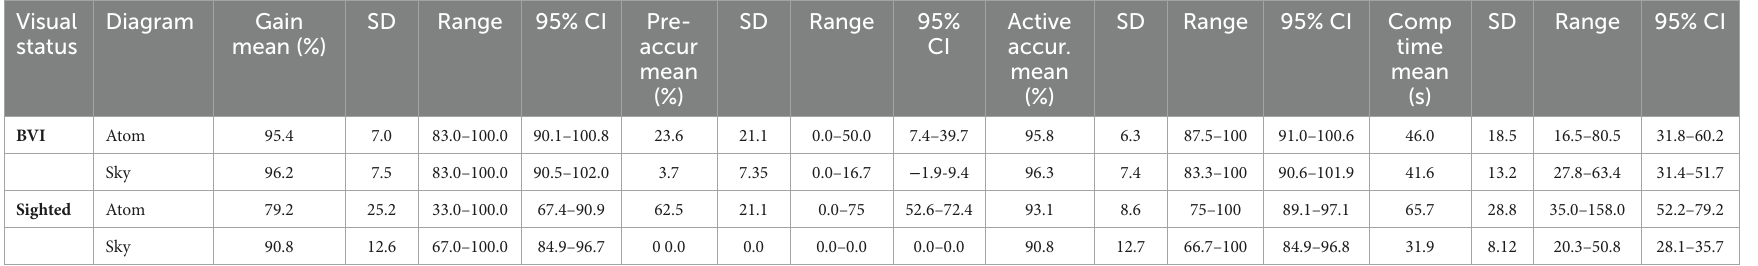
TABLE 4 Pre/post accuracy collapsed across condition mode.